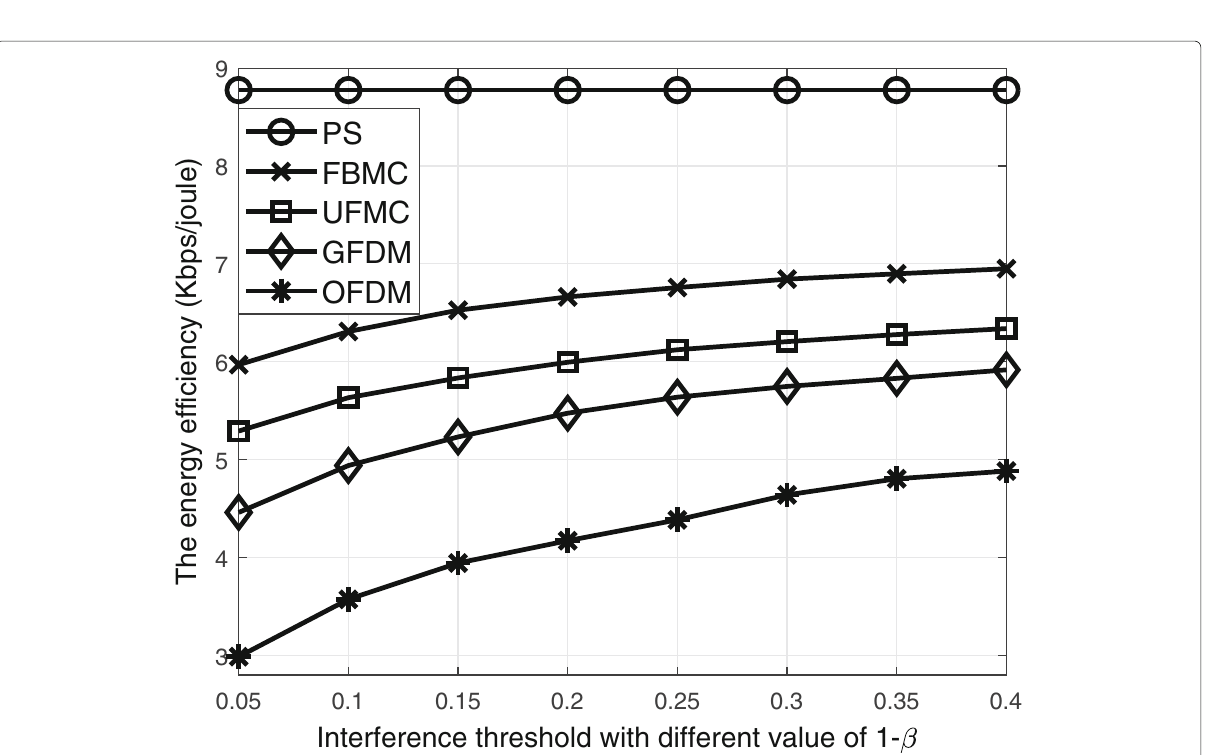
Fig. 8 Energy efficiency versus interference thresholds. The performance of the proposed algorithm using various modulation schemes versus different interference